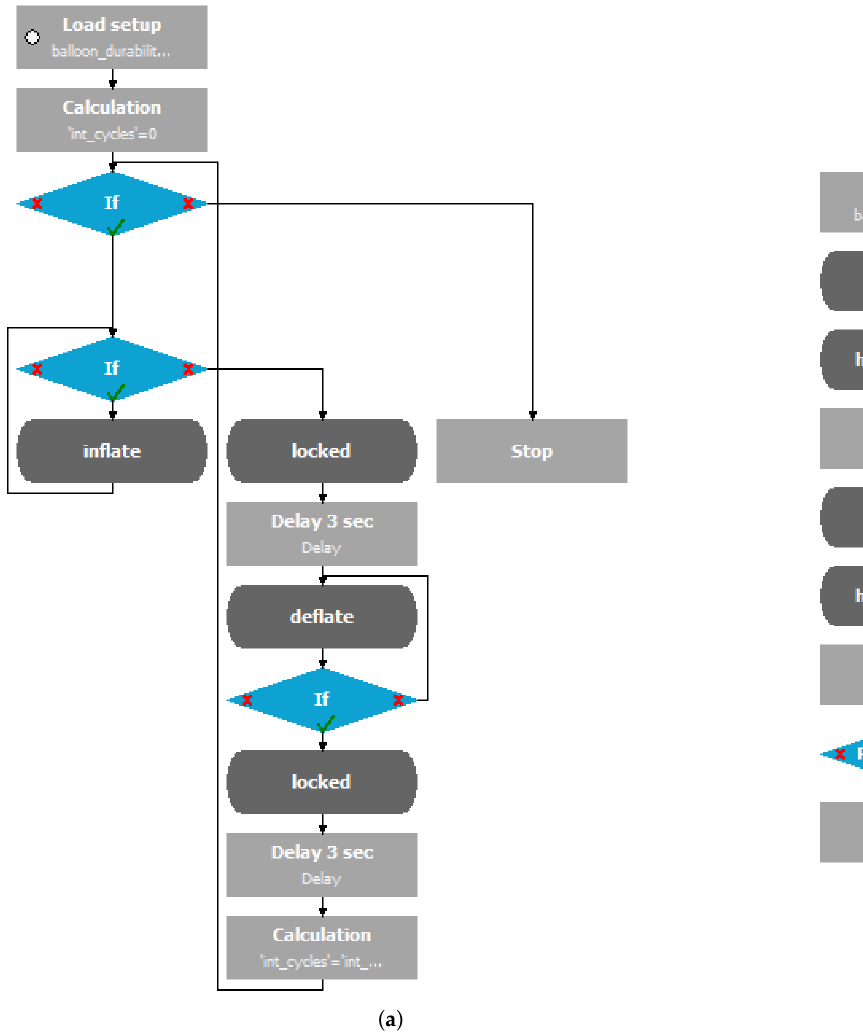
Figure 6. Balloon durability test—( a ) Before refactoring ( b ) After